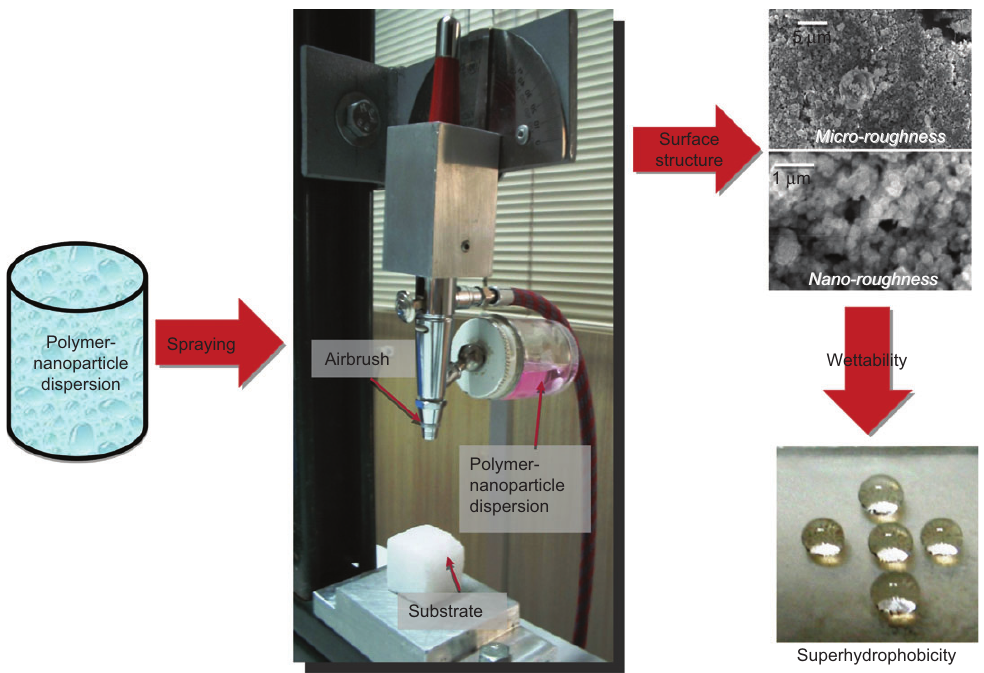
Figure 12 Static contact angle ( θ